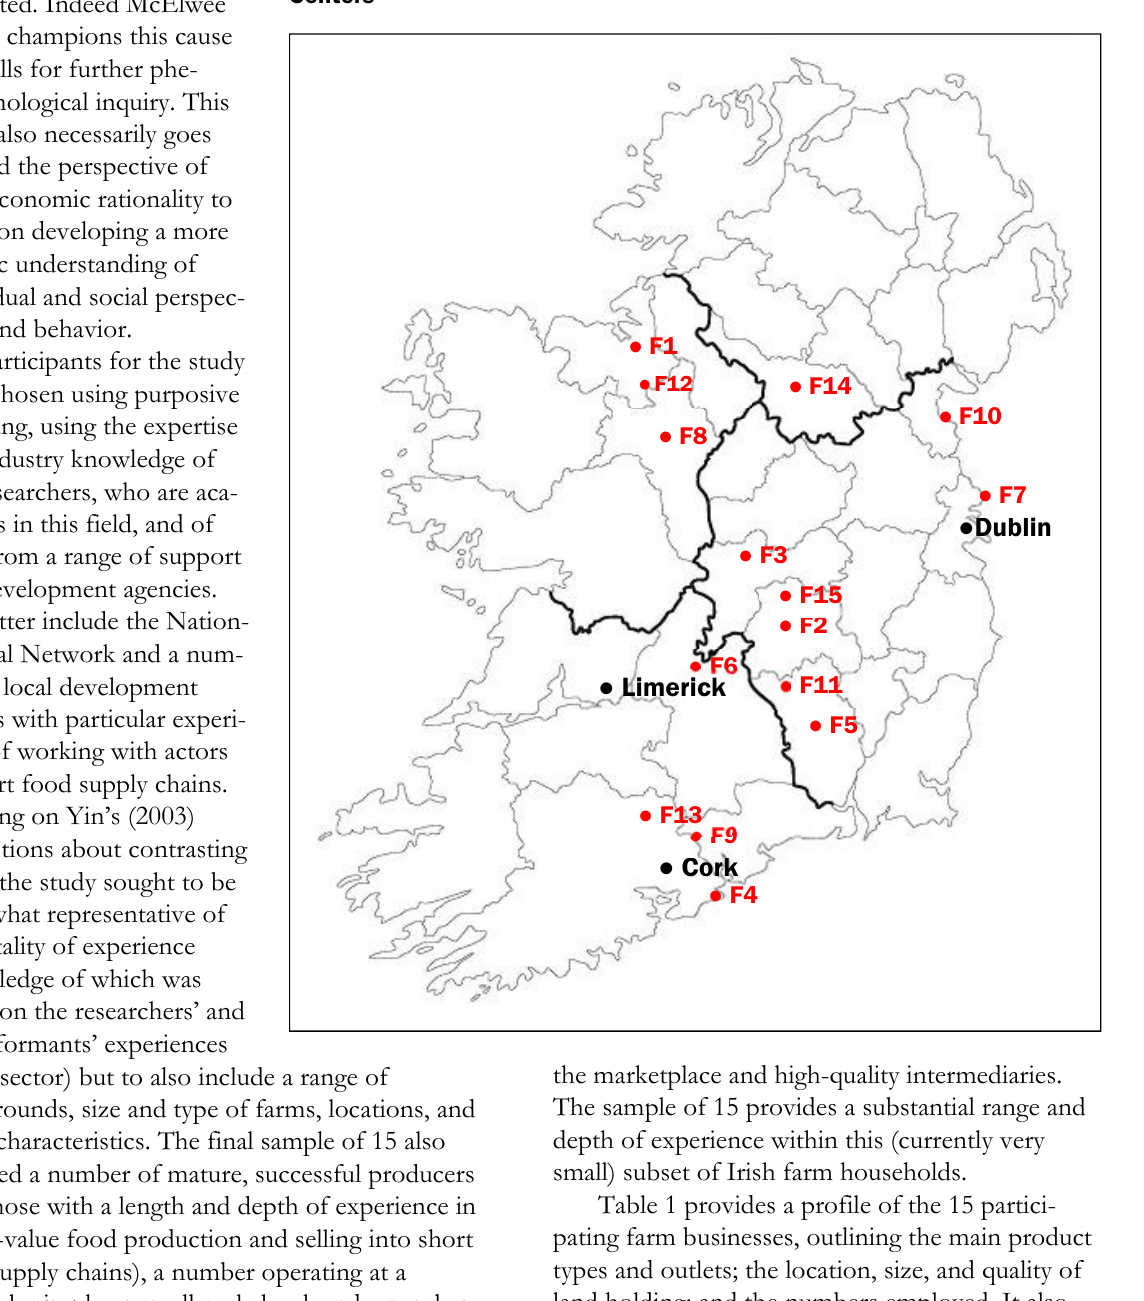
Figure 1. Individual Farm Businesses Mapped, Including Major Population